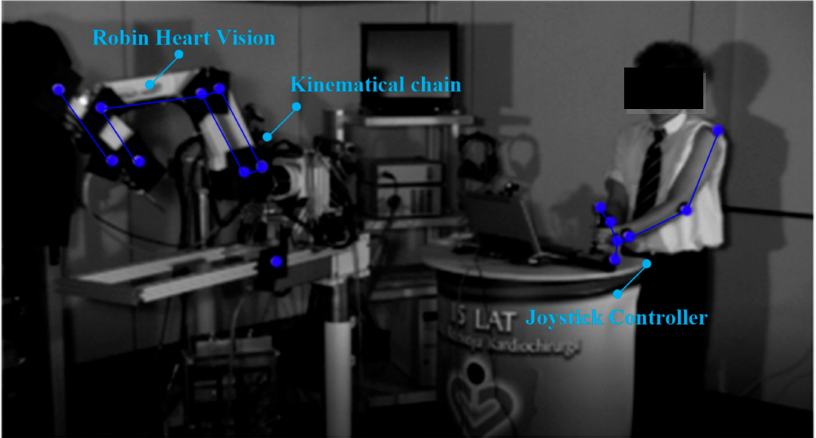
Figure 2. Robin Heart Vision surgical robot for soft tissue surgery and joystick controller and robot operator with reflective markers attached to the biokinematic chain.